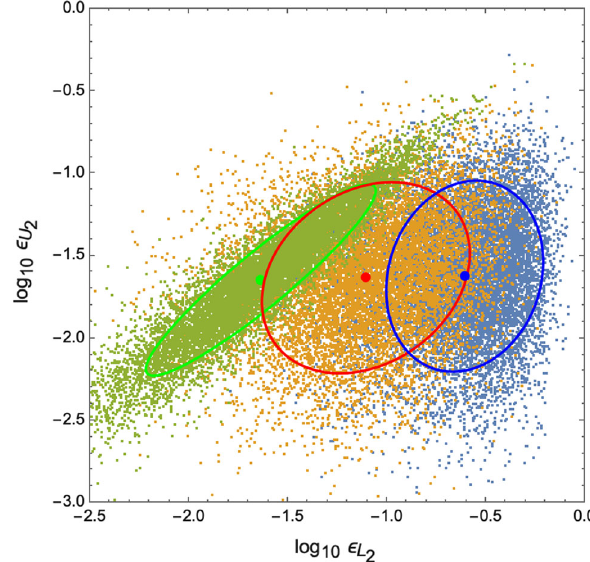
Fig. 5 Second-generation eigenvalues of E L and E U c in the SO ( 10 ) model for N = 5, a = 0 . 5, tan α = − 0 . 6, and b = 0 . 1(green), b = 0 . 8 (orange) and b = 1 . 4 (blue). The mean values and one-sigma contours are also shown in each case. The correlation coefficients are 0 . 93, 0 . 25, and 0 . 15 respectively. The increasing b parameter affects the U sector very little ( b U c = 0 . 05 b ), retaining a large hierarchy, while the L sector hierarchy is largely removed by the much larger b L = 0 . 6 b